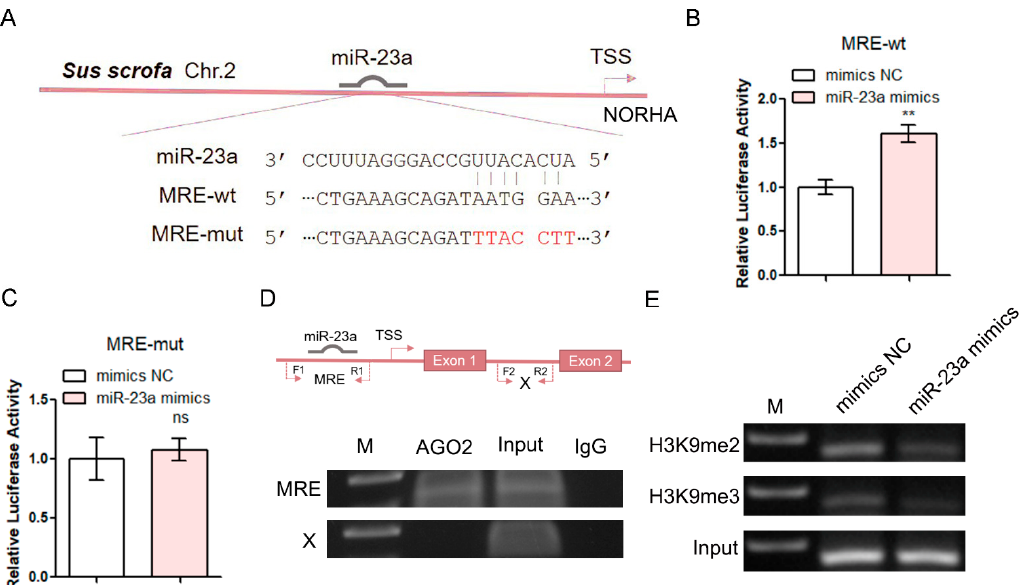
Figure 3. miR-23a enhances NORHA promoter activity by altering histone modification of the MRE motif. ( A ) Vector diagram of the wild type (wt) and mutated type (mt) of the MRE motif in the NORHA promoter. The red base is the mutation site. TSS, transcription start site. ( B , C ) Luciferase activity was detected in pGCs after being co-transfected with miR-23a mimics and a reporter vector containing the MRE-wt ( B ) or the MRE-mut ( C ). ( D ) ChIP assays were performed using an AGO2- specific antibody. The image contains a schematic diagram of the porcine NORHA gene structure (top) and ChIP images (bottom). F1/R1 and F2/R2 are the primers used to amplify the MRE site and X site, respectively. The X site is an intronic region of NORHA that does not contain the MRE of miR-23a. M, DNA marker. ( E ) ChIP assays were performed using H3K9me2- and H3K9me3-specific antibodies. Data are expressed as the mean ± S.E.M., and significance was tested using a t -test (ns, not significant, ** p < 0.01).